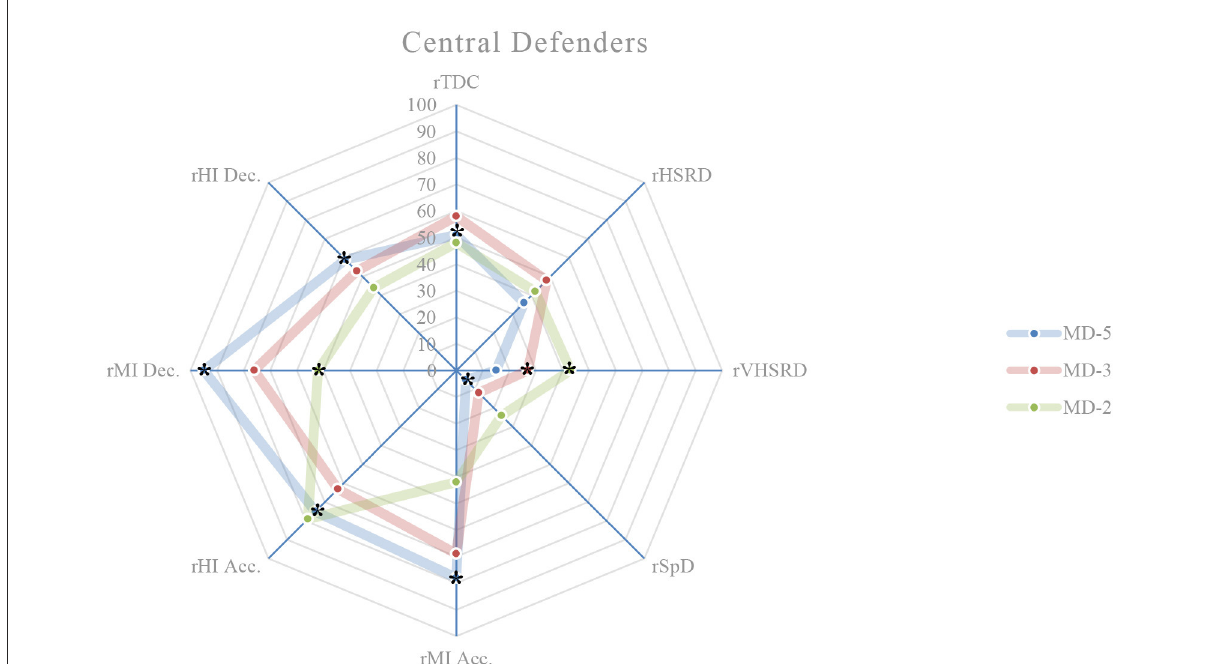
FIGURE1 Daily external load (based on MRef) of central defenders. *Location of the significant differences, p < 0.05.